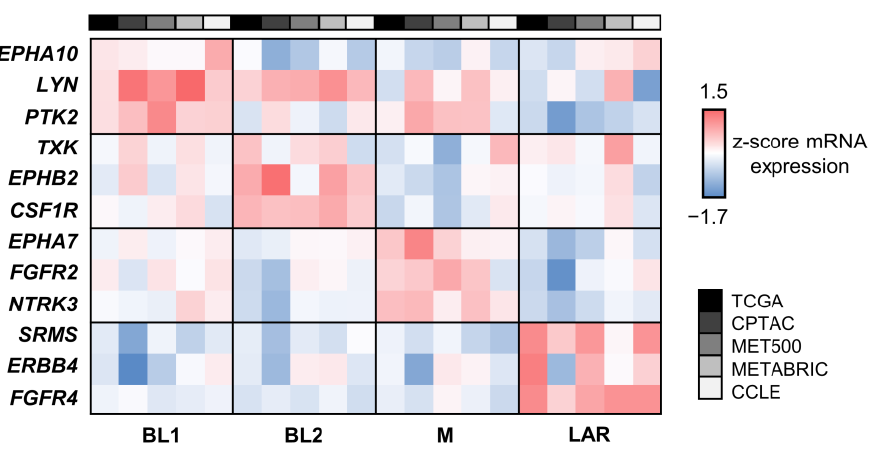
Figure 5. The comparison of the mRNA expression z-score of signature TK genes of each TNBC subtype. The heatmap displayed the mRNA expression z-score of the top three TKs that were unique in each TNBC subtype comparing among four TNBC datasets including TCGA, CPTAC, MET500, METABRIC, and CCLE. Each row represented DE TK genes, and each column represented the individual TNBC subtypes from different datasets. The color bar from blue to red showed the level of the mRNA expression z-score ascendingly.